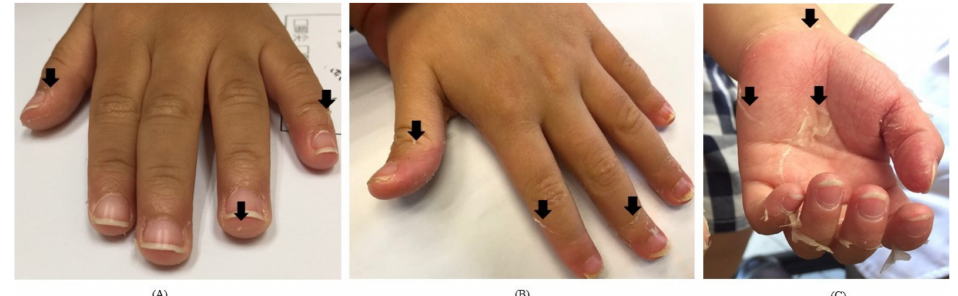
Figure 2. The desquamation of hands; the black arrows point out the margin of peeling; ( A ): grade 1; ( B ): grade 2; ( C ): grade 3.